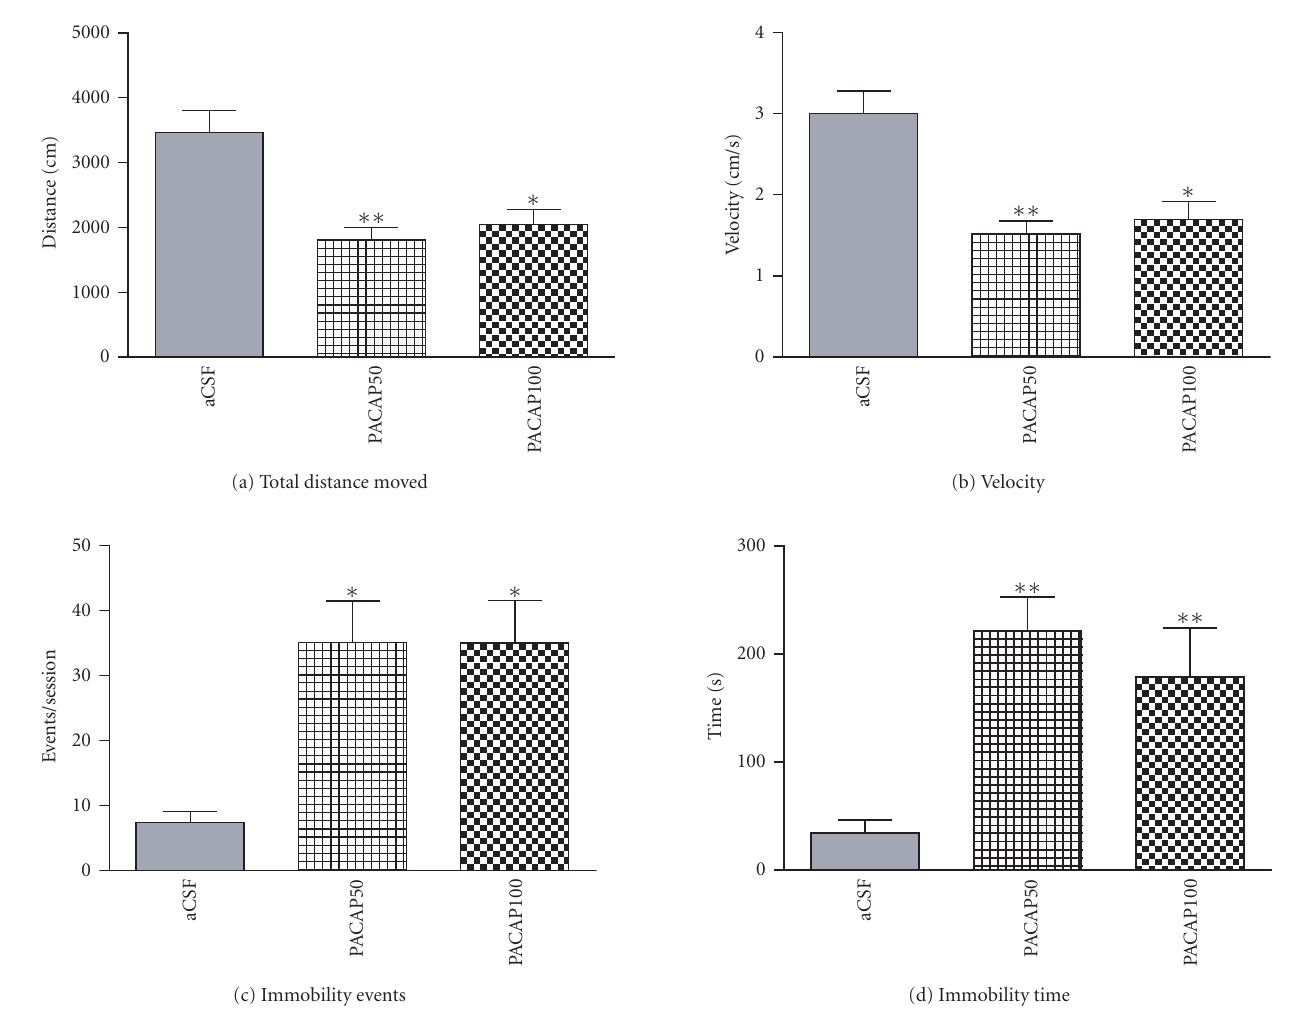
Figure 3: E ff ects of intra-CeA PACAP microinjection on locomotion parameters in shocked rats. Total distance moved (a) and mean move- ment velocity (b) were significantly reduced by intra-CeA PACAP microinjection. Immobility events (c) and total time spent on immobility (d) following probe-contact-induced shocks were increased by intra-CeA PACAP. ∗ P < . 05 and ∗∗ P ≤ . 001 compared to aCSF